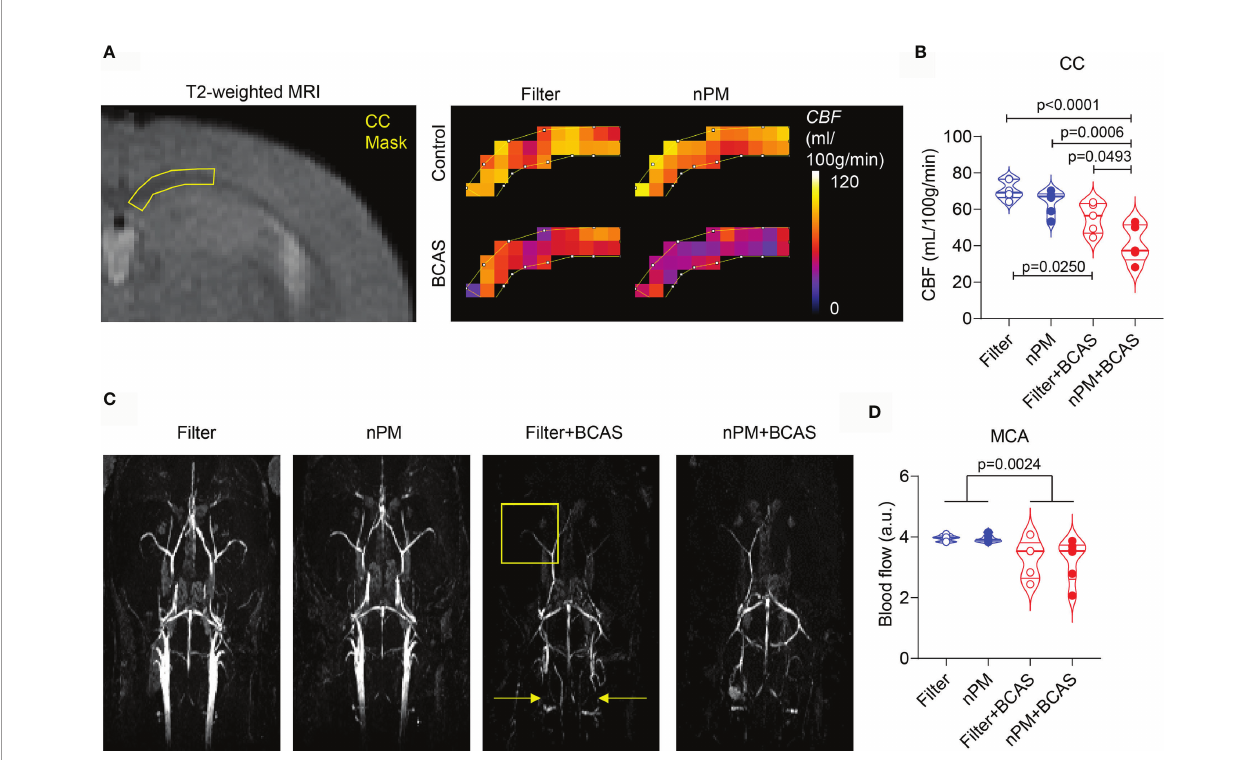
FIGURE 2 | nPM exposure worsens white matter hypoperfusion after bilateral carotid artery stenosis. (A, B) Corpus callosum cerebral blood fl ow (CBF) was measured in vivo by using dynamic susceptibility weighted MRI and gadolinium-based contrast agent. Regional cerebral blood fl ow values (CBF in mL/100g/min) were mapped (A) and quanti fi ed (B) in the corpus callosum area. In panel (B) n=6 in fi lter and nPM groups and n=5 in fi lter+BCAS and nPM+BCAS groups. (C) Time-of- fl ight angiography was used to visualize arterial angioarchitecture in mice and is shown as maximum intensity projections. Yellow arrows indicate placement of microcoils around carotid arteries of hypoperfused mice and yellow square indicates the middle cerebral artery area, which was quanti fi ed in (D) . In panel (D) n=6 in fi lter, nPM and nPM+BCAS groups and n=5 in fi lter+BCAS group. P-value indicates BCAS effect in panel (D) . Data is presented as violin plot with median and quartiles. 1-way ANOVA (B) and 2-way ANOVA (D) and Bonferroni Post Hoc tests were used for statistical testing. CC, corpus callosum; MCA, middle cerebral